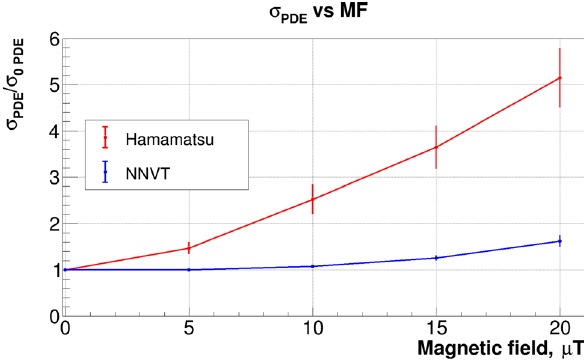
Fig. 43 PDE uniformity versus magnetic field strength. Indicated data points represent means and standard deviations of the tested samples (9 HPK PMTs and 15 NNVT